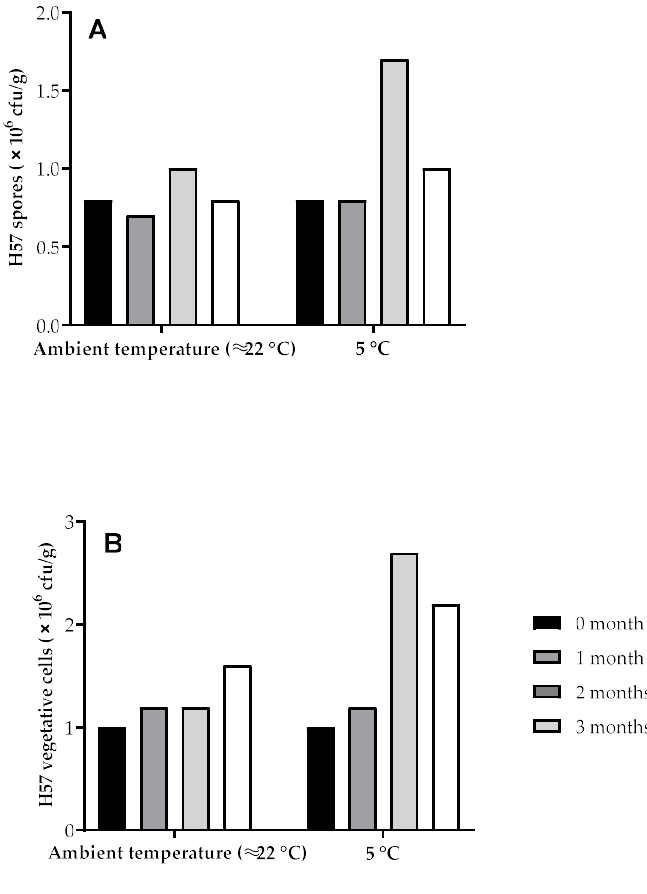
Figure 2. Enumeration of H57 spores ( A ) and vegetative cells ( B ) from the pellet treatments.